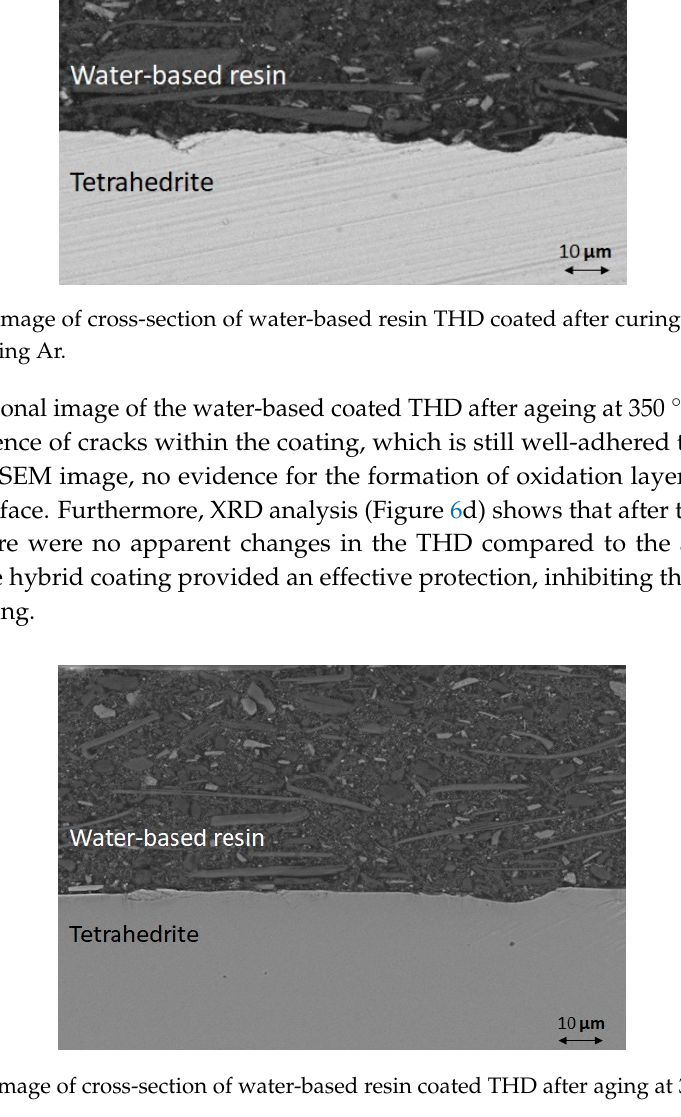
Figure 9. SEM image of cross-section of water-based resin coated THD after aging at 350 °C, dwelling time 48 h, in air.